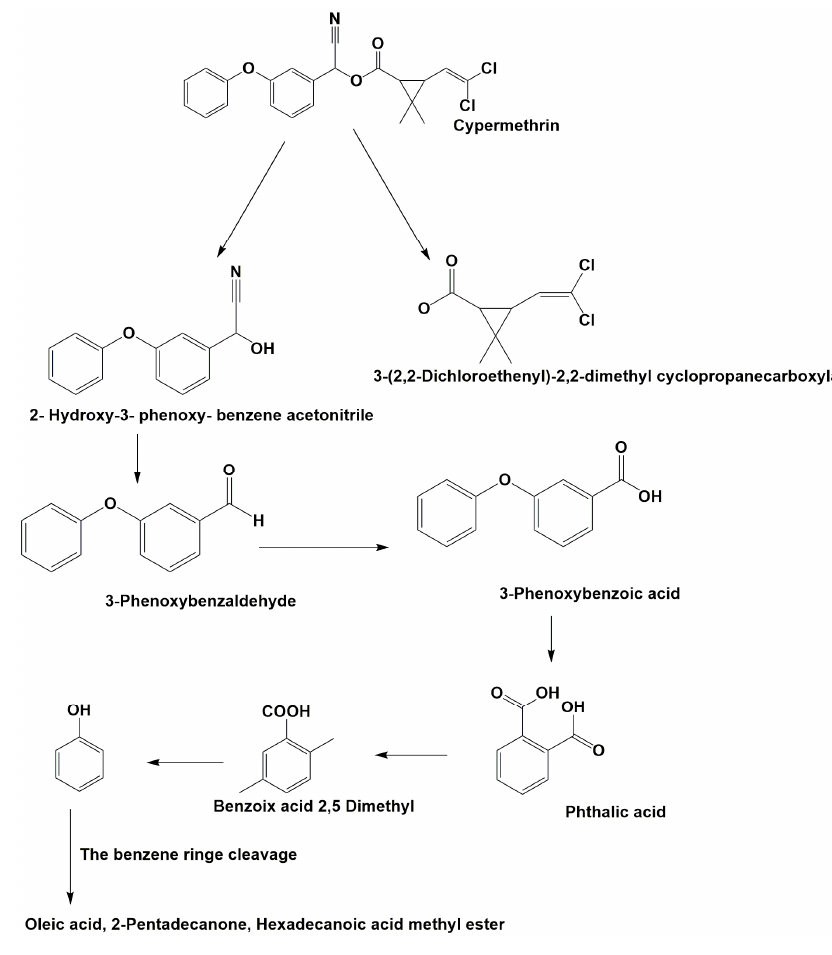
Figure 5. Metabolic pathway of cypermethrin degradation of strain SG4.